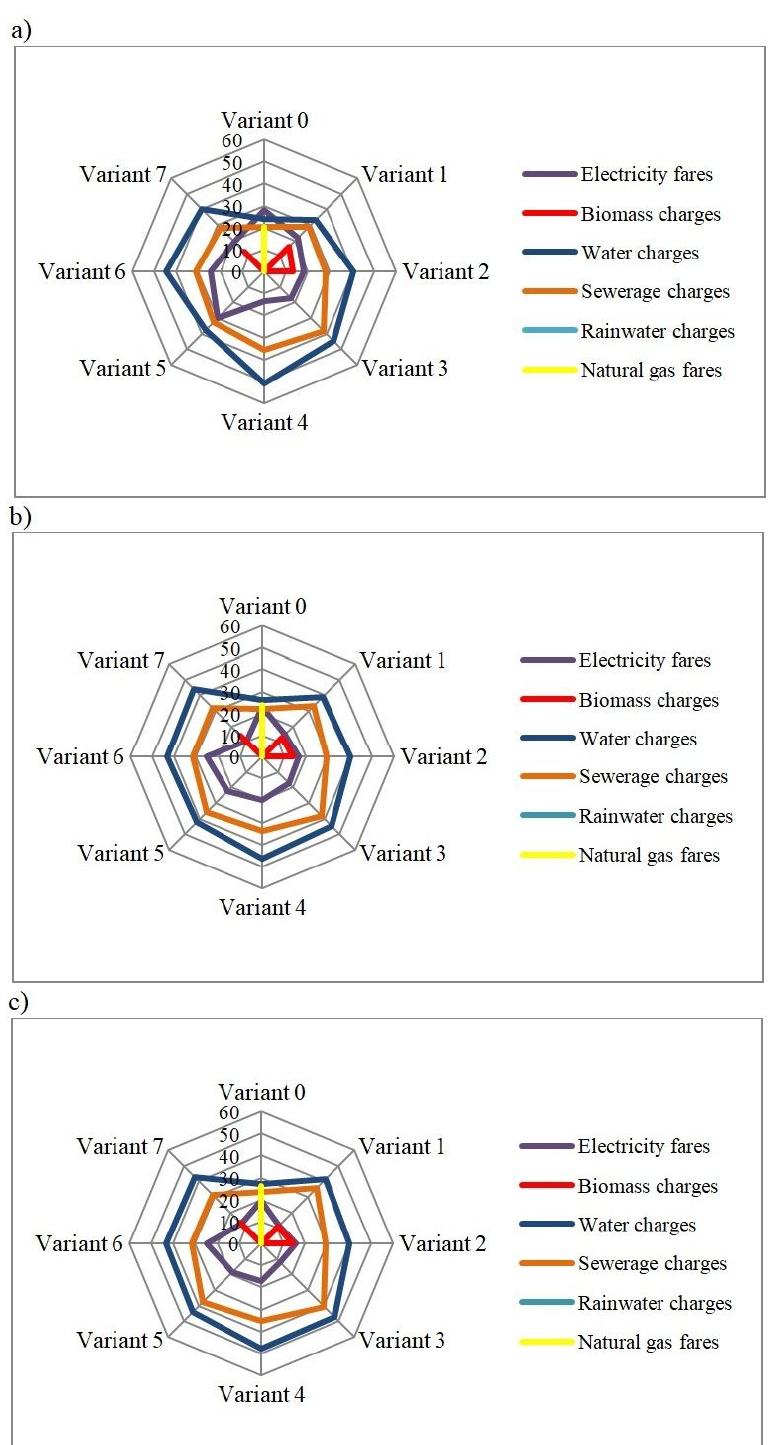
Figure 14. The structure of operating costs incurred over a period of 25 years for a computational case: ( a ) O c = 2 persons and l sh = 5 min/person/day, ( b ) O c = 4 persons and l sh = 8 min/person/day, ( c ) O c = 6 persons and l sh = 10 min/person/day.